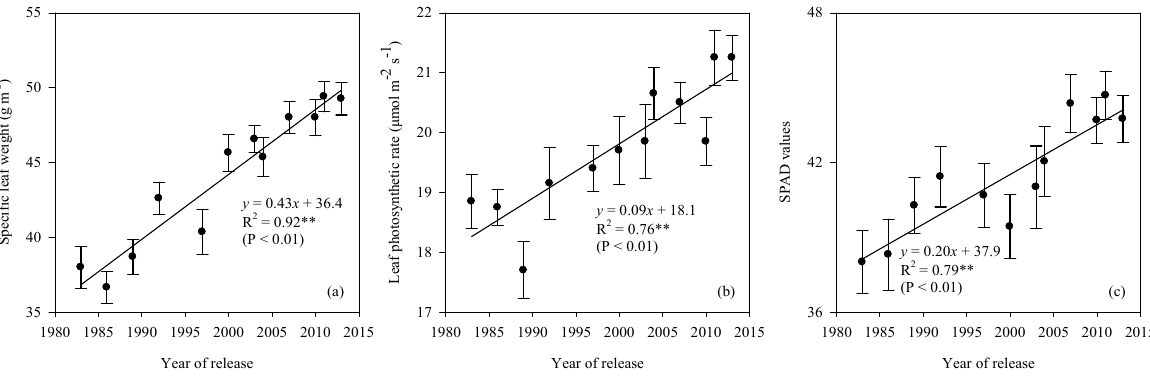
Figure 7. Relationships between year of release and specific leaf weight ( a ), leaf photosynthetic rate ( b ), and SPAD values ( c ) at full heading stage of rice cultivars. Data were fitted by linear regression ( y = a x + b). In the linear regression, x was reassigned as years after 1983; for example, x was valued as 1 in 1983 and so on. **, significant at the 0.01 probability level according to the LSD test. Vertical bars represent ± standard error of the mean ( n = 6).